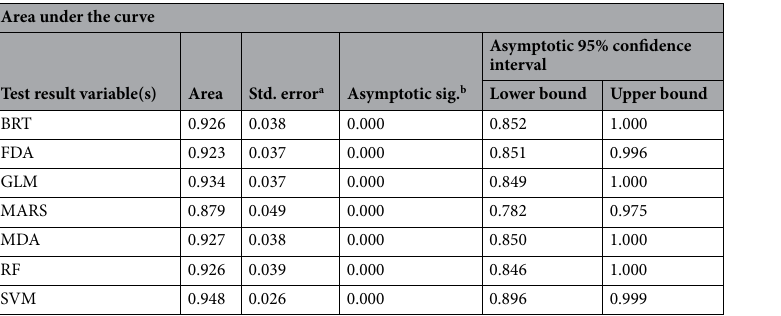
Table 4. Predictive performance of the seven applied models in the validation process of gully heads 2020. The test result variable(s): MARS has at least one tie between the positive actual state group and the negative actual state group. Statistics may be biased. a Under the nonparametric assumption. b Null hypothesis: true area = 0.5.